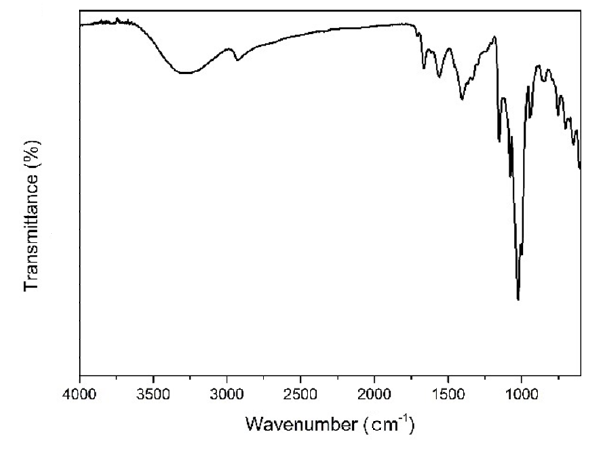
Figure 2 . IR spectrum of AEA – β – CD. Figure 2. IR spectrum of AEA– β